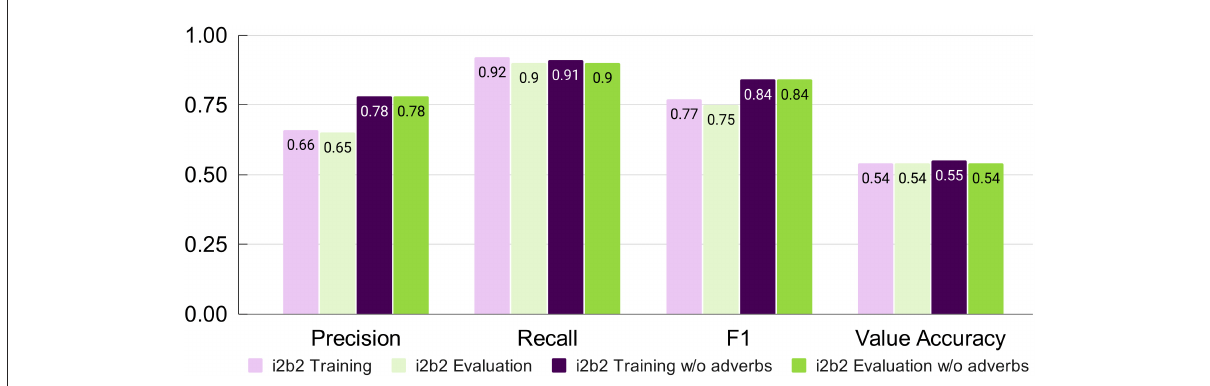
FIGURE2 Chrono’s performance on the i2b2 training and evaluation data sets after conversion changes and algorithm improvements using span-based P, R, and F1